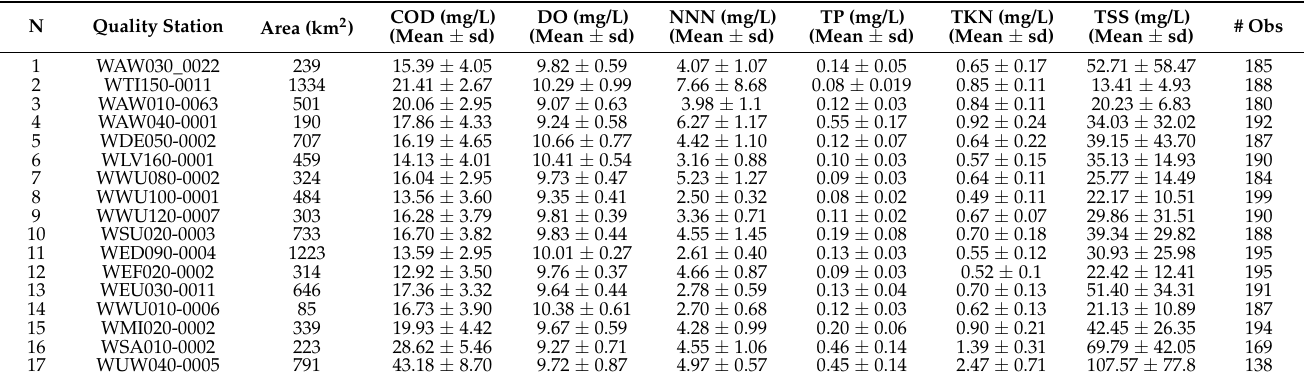
Table 3. Main characteristics of study drainage areas and their water quality